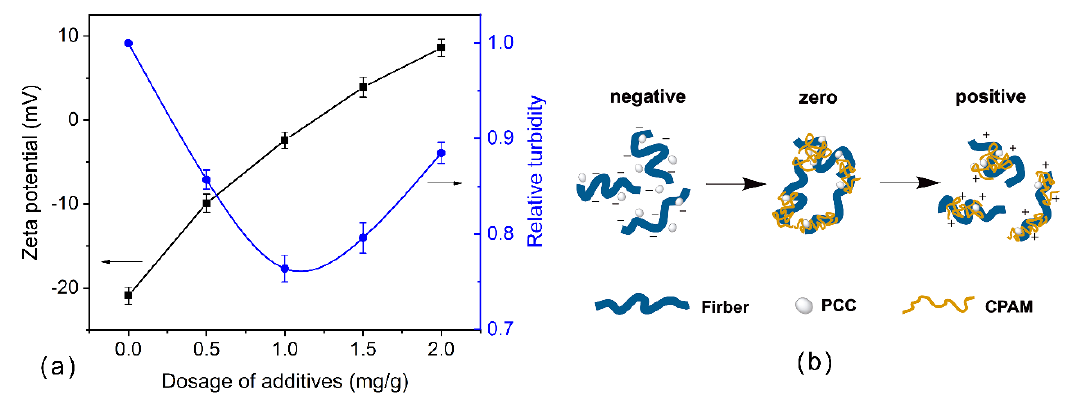
Figure 4. ( a ) Zeta potential and relative turbidity of pulp at varying proportions of cationic polyacrylamide (CPAM), and ( b ) schematic diagram of the interaction between pulp and CPAM.